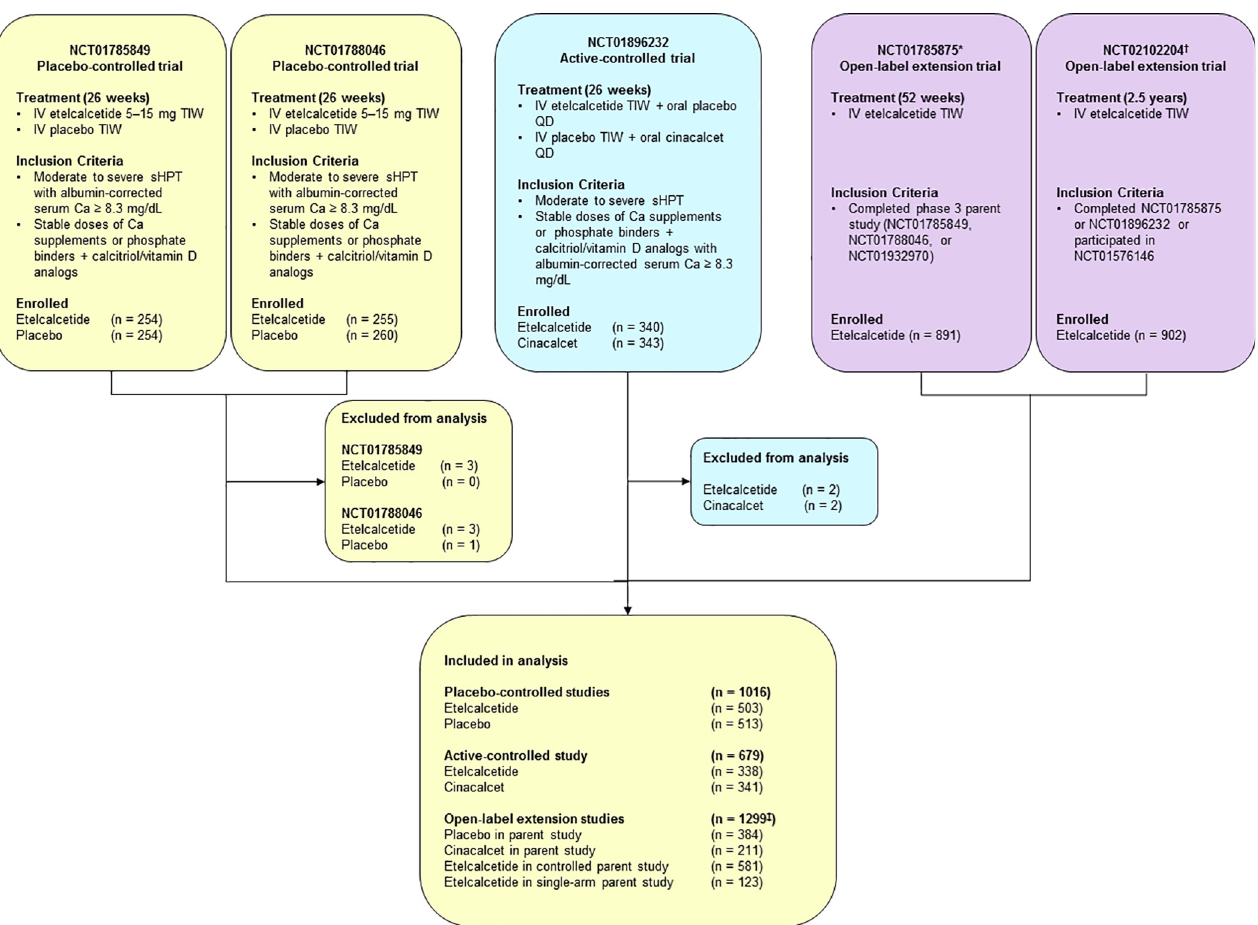
Fig 1. Trials included in the integrated safety analysis. � Trial NCT01785875 also contains data from patients enrolled from a single-arm parent trial (i.e., trial NCT01932970). † Trial NCT02102204 also contains data from patients enrolled from a phase 2 parent trial (i.e., trial NCT01576146). ‡ Indicates unique patients in the OLE pool. Ca = calcium; QD = every day; IV = intravenous; sHPT = secondary hyperparathyroidism; TIW = three times